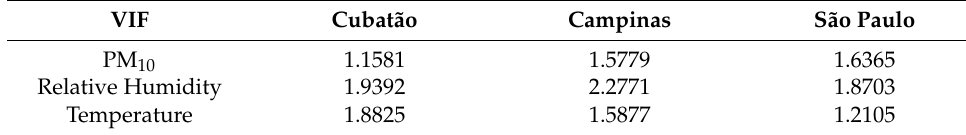
Table 2. VIF test results for